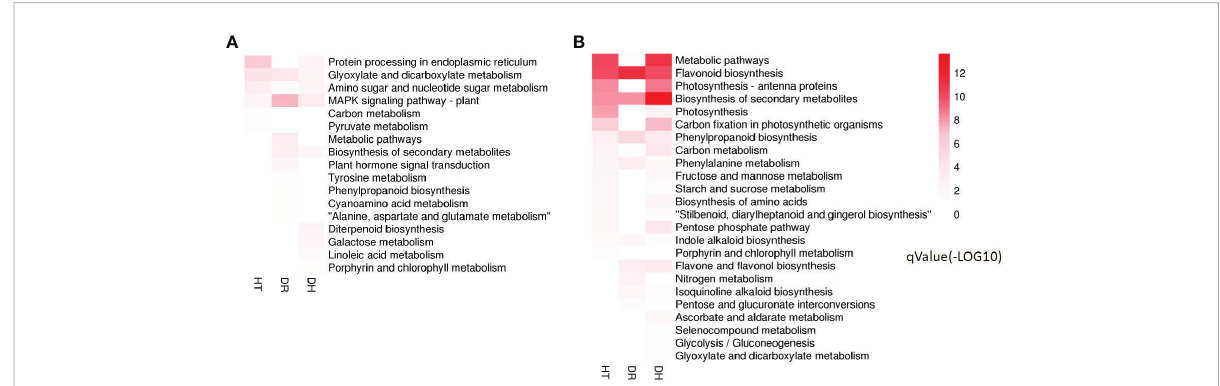
FIGURE 5 Heatmap of the q -value signi fi cance of KEGG pathways showing DEG enrichment in response to HT, DR, and DH stresses compared with CK. (A) Up-regulated DEGs under HT, DR, and DH stresses. (B) Down-regulated DEGs under HT, DR, and DH stresses. The color scale ranges from white (no DEGs), light-red (DEGs with low q values) to red (DEGs with high q values). HT, heat stress; DR, drought stress; DH, drought and heat